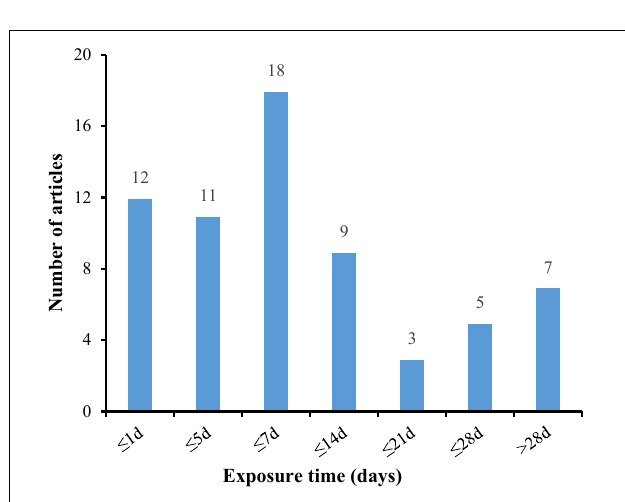
FIGURE 3 | The number of articles employing various exposure times to treat mollusks with